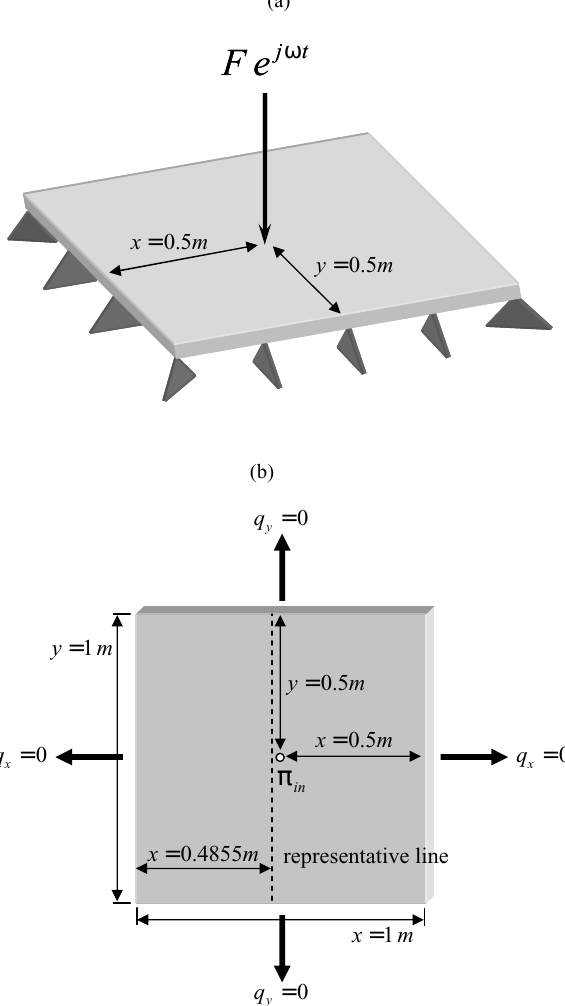
Fig. 4. Simply-supported rectangular plate. (a) Geometry of plate with external transverse harmonic load. (b) Energy flow model with dimensions and zero energy flow boundary conditions. applied. If we were able to integrate these equations in closed form and solve them for the fictitious source φ or the initially known, boundary values of e and q , then the solution would be exact. But this operation is